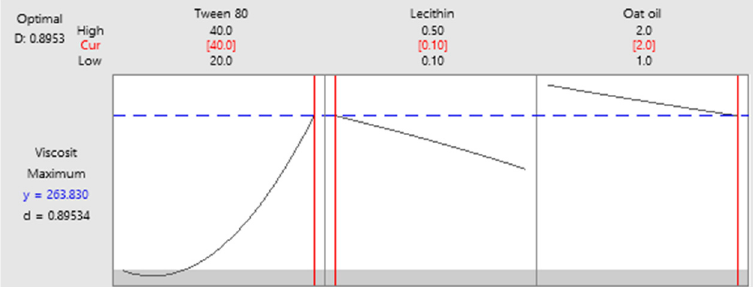
Figure 15. Predictive optimization plot for viscosity response as function of three setting parameters: X 1— maximized, X 2— no constraints, and X 3— maximized, with a composite desirability of 0.8953.